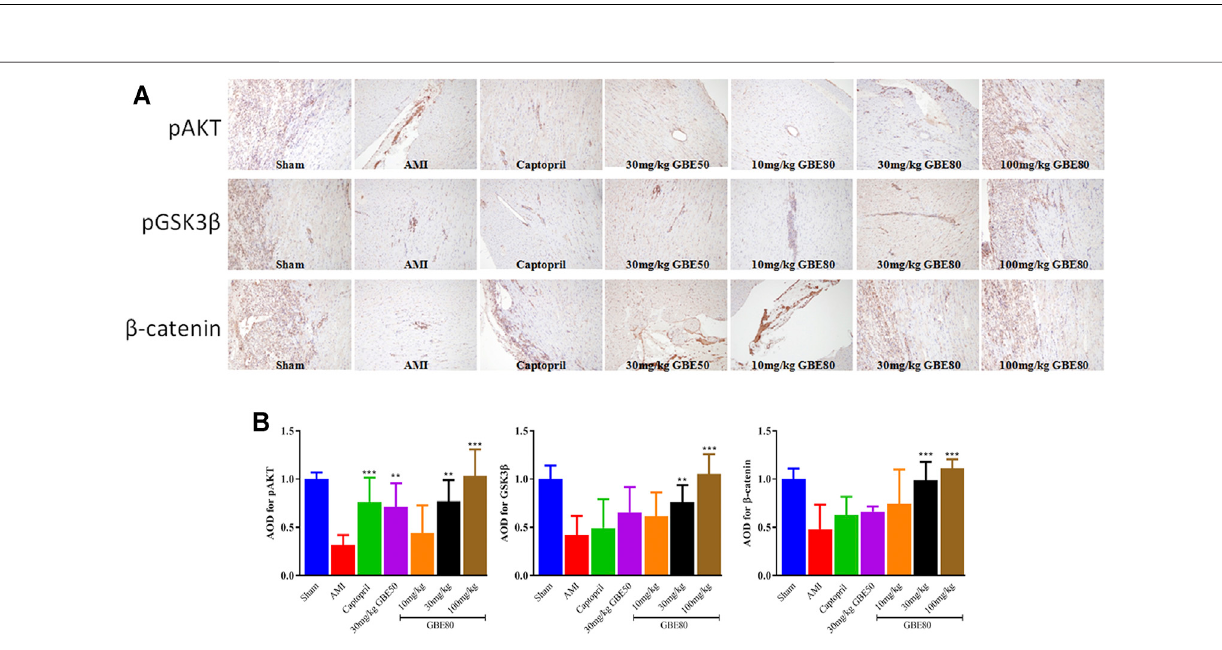
Frontiers in Molecular Biosciences |